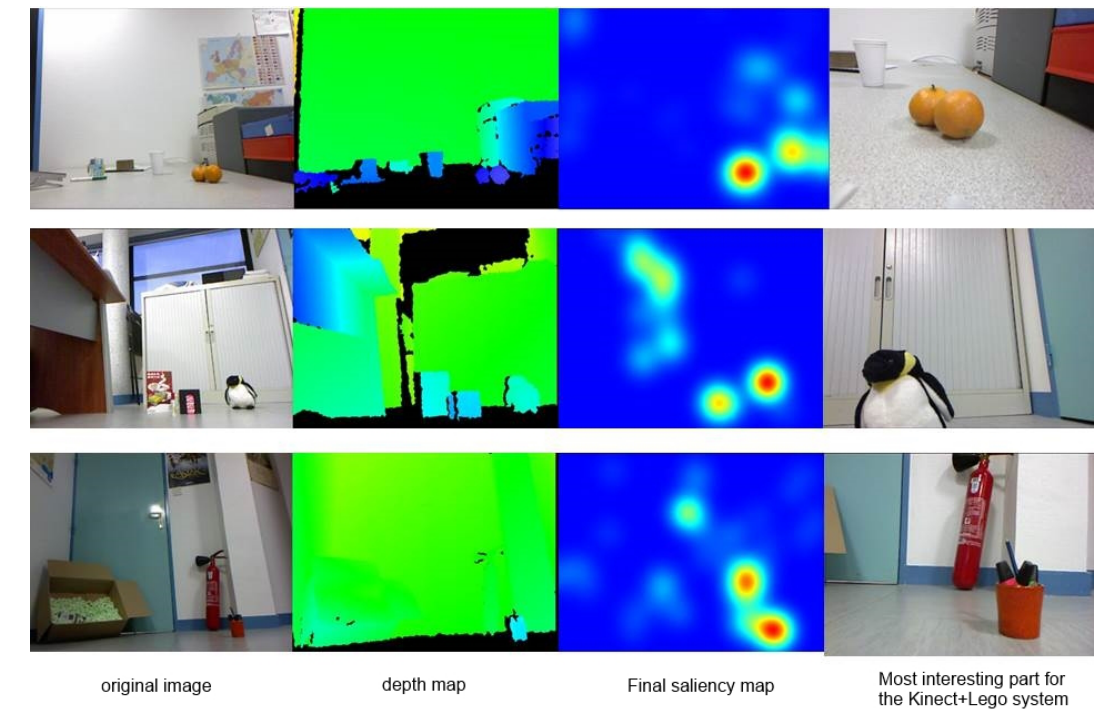
Figure 10. Sample of experiments realised. Left column: initial point of view of CuriousMind. Second column: raw depth map, third column: saliency maps, fourth column: picture taken by CuriousMind once it reached the interesting objects.